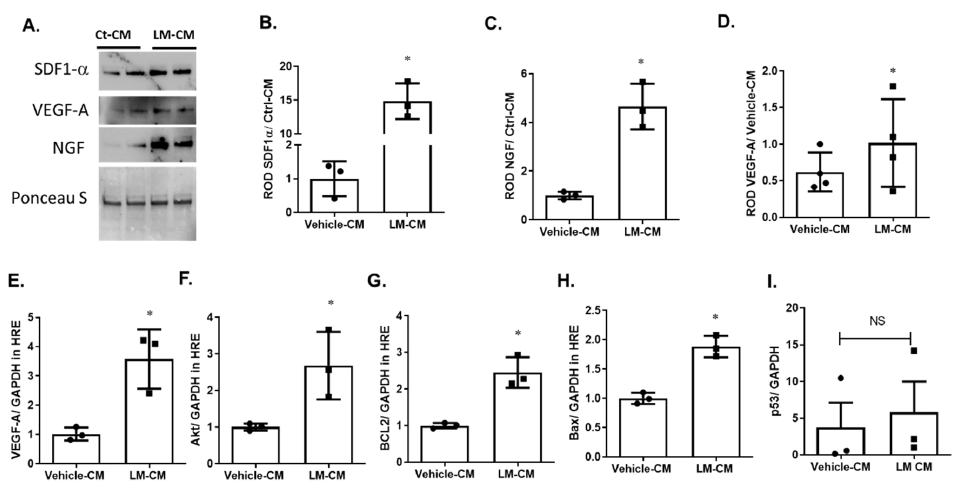
Figure 7. Modulating p75 NTR on MSCs using LM11A-31 improved their secretome and improved paracrine effect in HREs. Representative Western blotting ( A ) and statistical analysis of MSCs secretome treated with the pharmacologic modulator of p75 NTR ; LM11A-31. ( B – D ) showing ~14.9-Fold increase in SDF-1a ( B ), 1.6-Fold increase in VEGF-A ( C ) and ~4-Fold increase in NGF ( D ). * p < 0.05, Significance was detected by unpaired Student t-test, n = 3. RT-PCR analysis showed that treatment of HREs with CM of LM11A-31-treated MSCs significantly increased gene expression of the survival factor transcripts VEGF-A ( E ), Akt ( F ), Bcl-2 ( G ) and some of the apoptotic markers, such as Bax ( H ), but not p53 ( I ). *, Significant at p < 0.05; NS, not significant. Significance was detected by unpaired Student t-test, n =